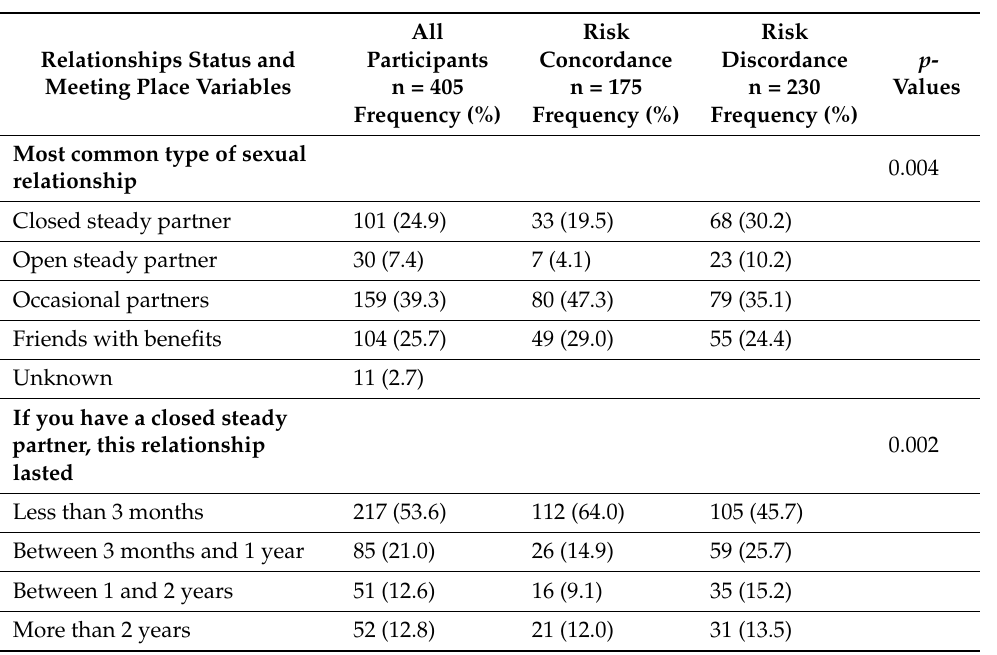
Table 3. Characteristics of relationships and meeting places based on the absence or presence of HIV risk discordance. p -values from Student’s t-test for continuous variables and chi-squared test for categorical